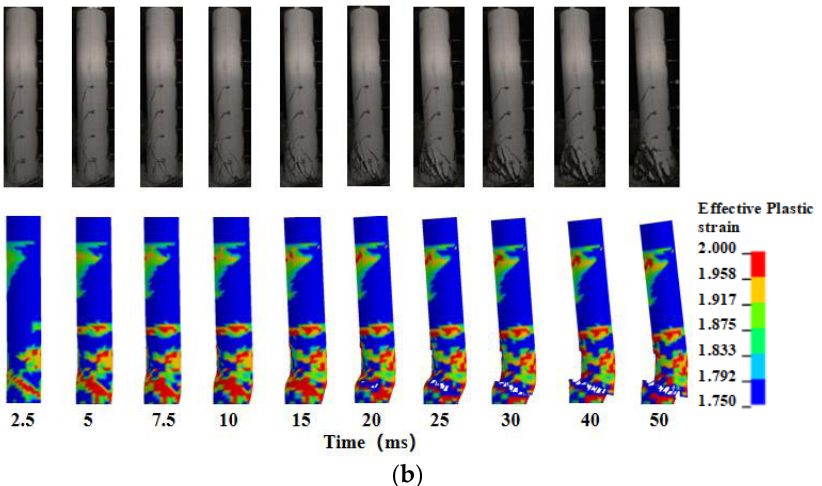
Figure 5. Comparison of impact process: ( a ) column C3H0; ( b ) column F3H0.